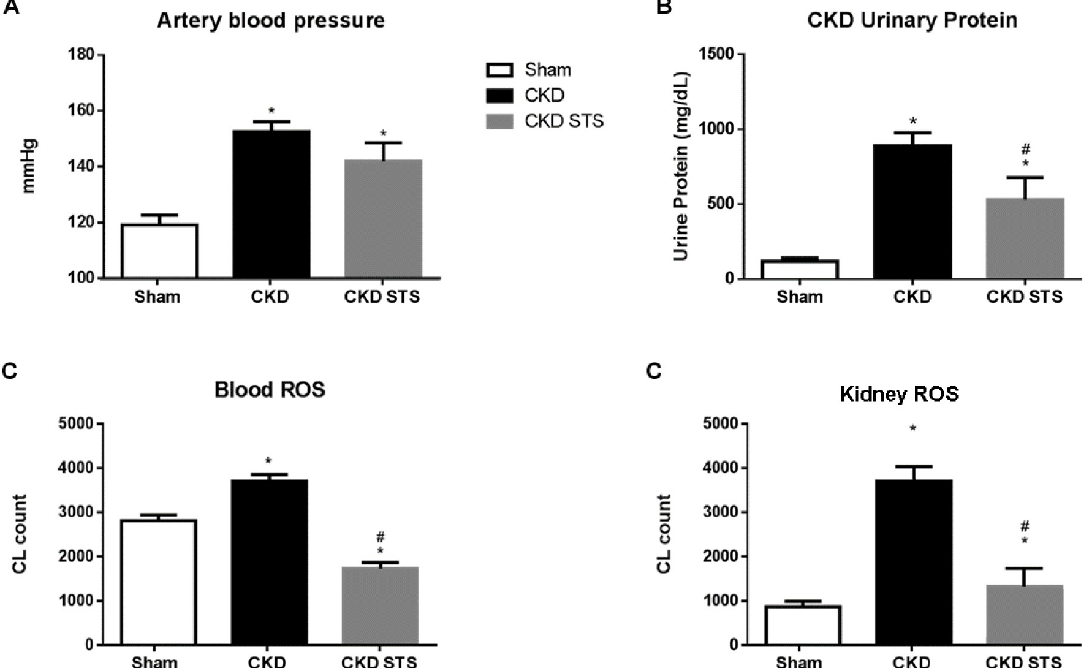
Fig 3. The STS effect on CKD induced renal hypertension (A), urinary protein (B), blood ROS (C) and kidney ROS amount (D). Our data show that the elevated arterial blood pressure, urinary protein, blood and kidney ROS amount are found in the CKD rats, whereas the increased level of urinary protein, blood and kidney ROS amount is reduced in STS treated CKD rats (CKD STS). All the data are expressed as mean ± SEM (n = 6). � P < 0.05 vs. Sham. # P < 0.05 vs. CKD.